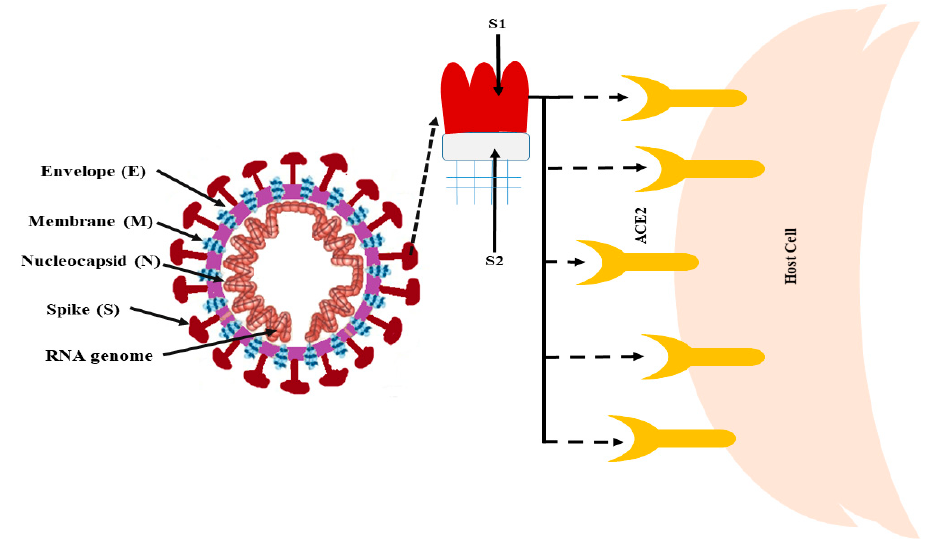
Figure 2. Basic structure of SARS-CoV-2 and its interaction with the host cell. ACE2, an- giotensin-converting enzyme 2. Figure 2 is available under an open-access Creative Commons Attribution License (CC-BY).